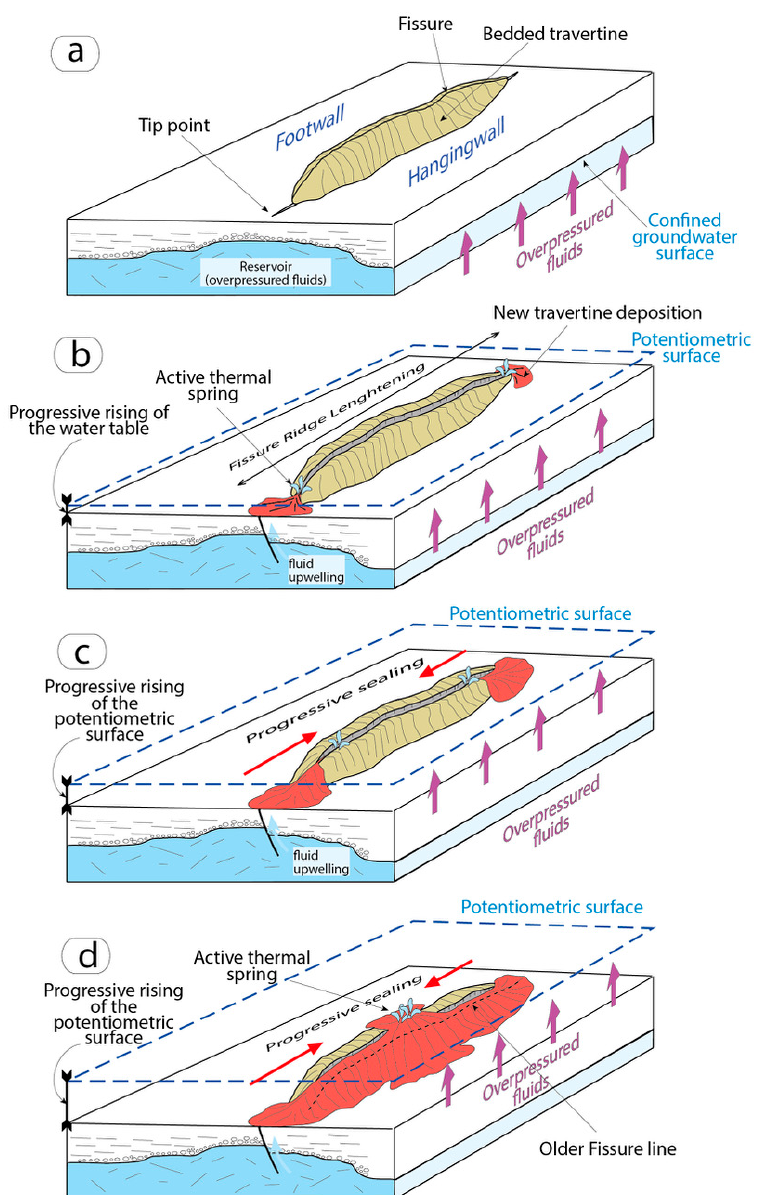
Figure 13. Schematic illustration of the conceptual mechanism controlling the development of a travertine fissure ridge based on the interplay between potentiometric surface level fluctuations and fracture sealing. a ) The fissure ridge during a tectonically quiescent period; at that time, the permeability was totally destroyed as a result of fracture sealing by Ca-carbonate veins. b ) After a tectonic pulse the fault reactivates, reopening previously sealed fractures and allowing the over- pressured fluids to rise. Fluids discharge at the tip zones; here flow is favoured by the hydraulic gradient. c – d ) Progressive fluid flow seals the fractures at the ends of the ridge; consequently, the springs have to migrate toward the higher portions of the ridge up to the highest part ( d ). At that time, fracture sealing progressively inhibits fluid flow and the travertine deposition stops. A sub- sequent period of travertine deposition and fluid flow can be guaranteed by a new tectonic pulse (from [11], re-drawn).